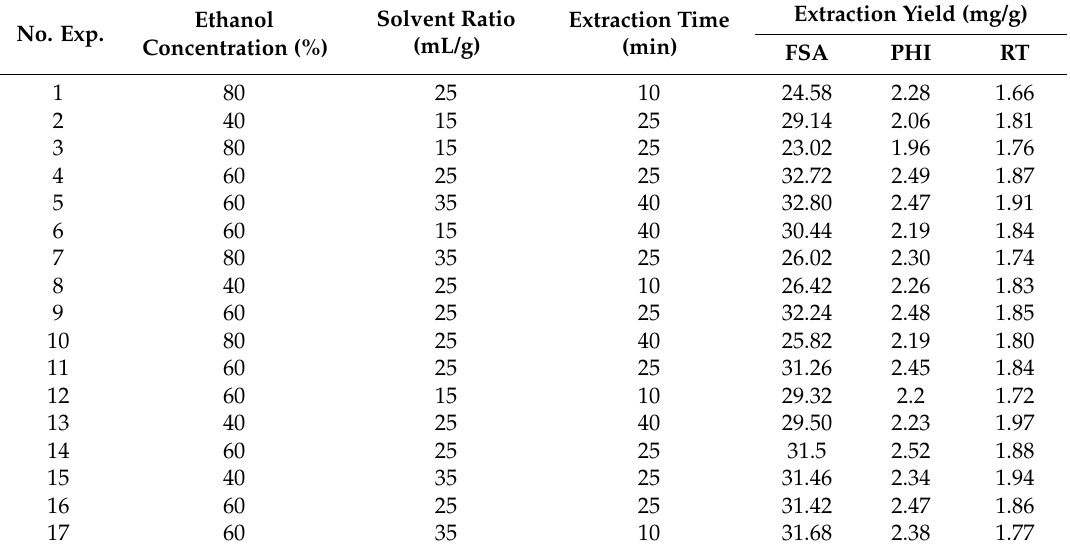
Table 1. Box–Behnken design and the responses measured.